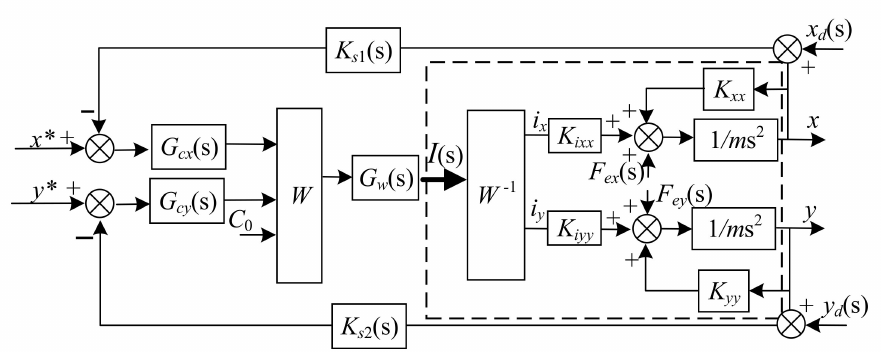
Figure 5. Closed-loop equivalent control schematic diagram of the entire system.